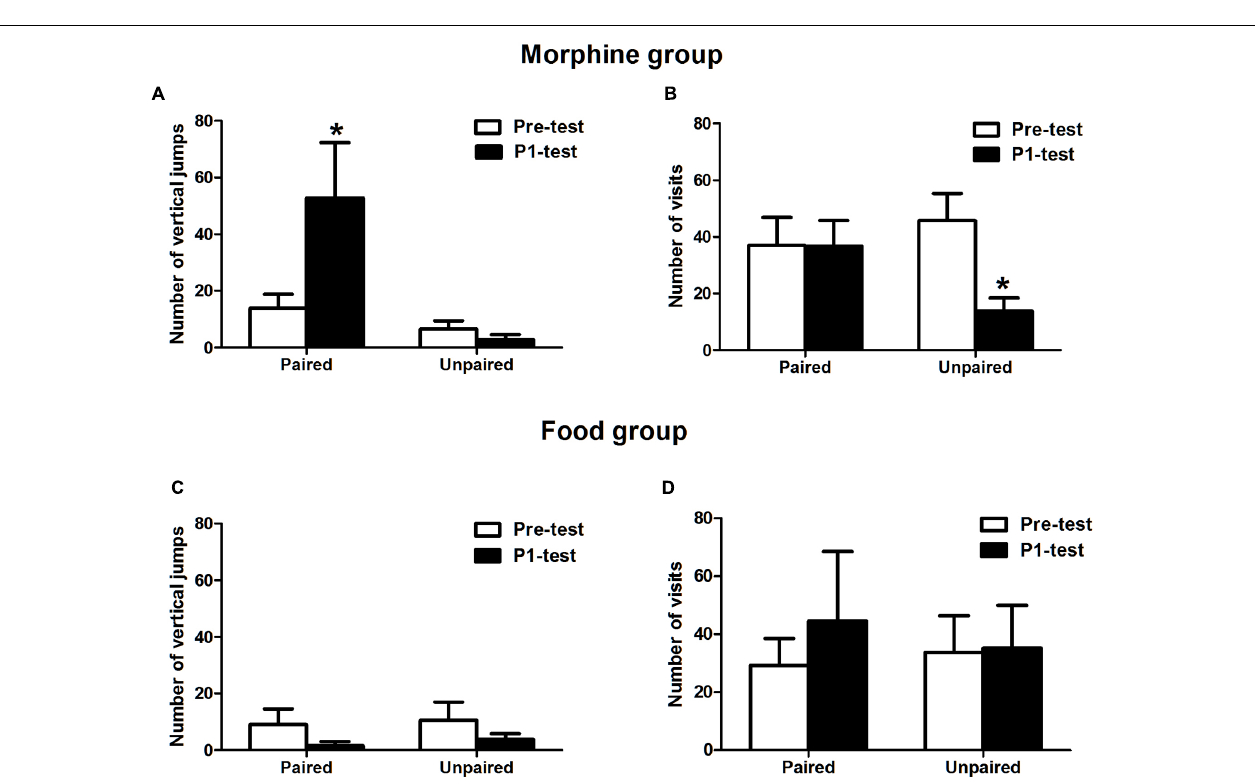
FIGURE 2 | Variations of psycho-activity and seeking behaviors on morphine and food CPP. (A) The vertical jumps of the morphine conditioned groups increased in morphine-paired chamber. (B) The visits number of the morphine-conditioned tree shrews decreased in saline paired chamber. (C) The vertical jumps number of the food-conditioned tree shrews was stable in both chambers and decreased compared to Pre-test. (D) The visits number in food group maintained stable. Data were expressed as the means ± SEM, n = 4. ∗ p < 0.05.